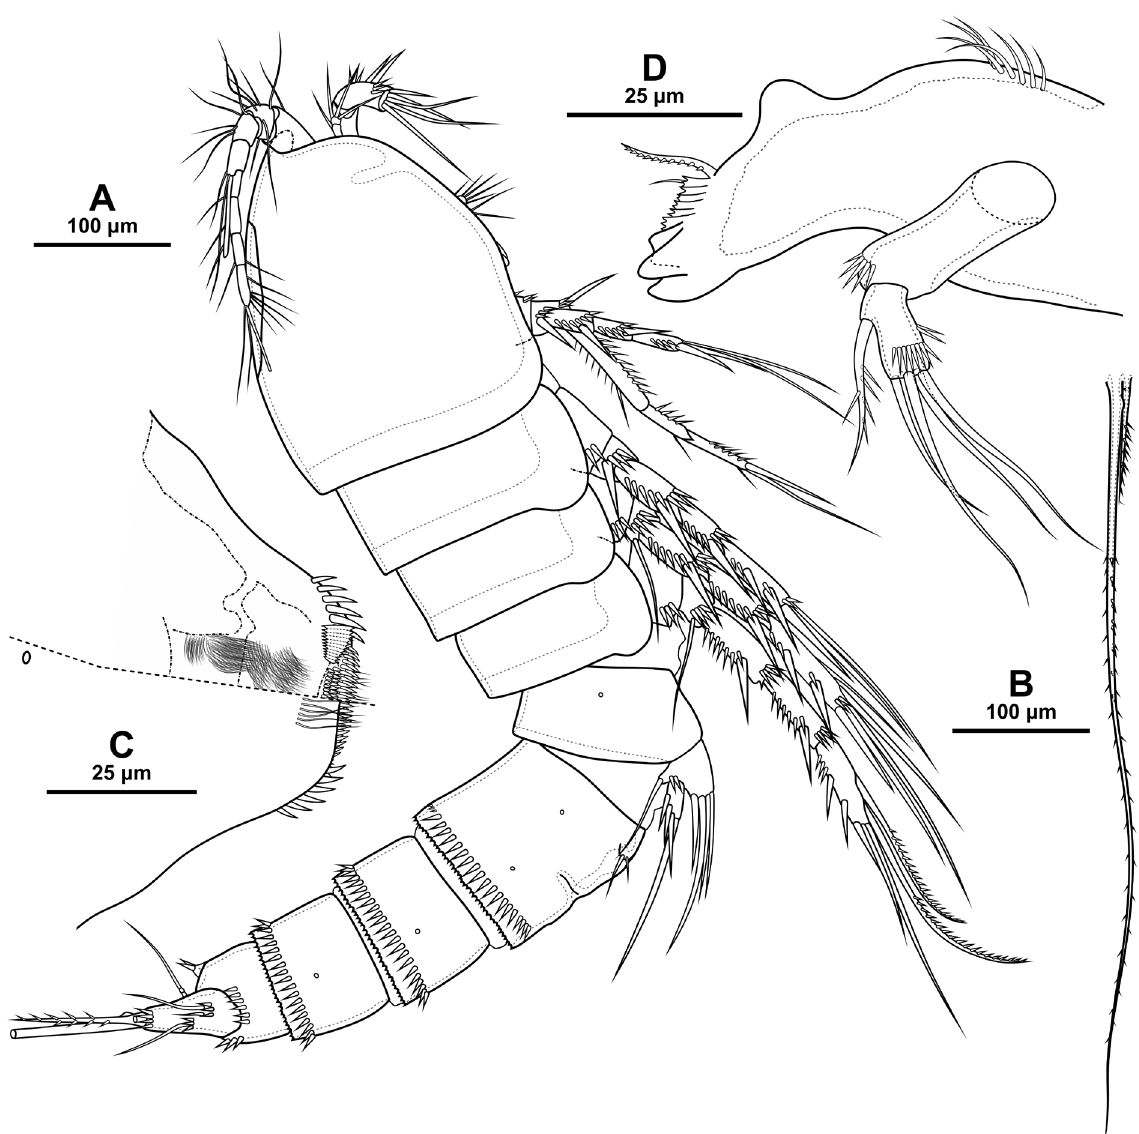
Fig. 1. Canthocamptus waldemarschneideri sp. nov. A . Paratype, ♀ (KFU BP 544/4); habitus, lateral view. B–D . Holotype, ♀ (KFU BP 544/1). B . Caudal setae IV and V. C . Labrum. D .